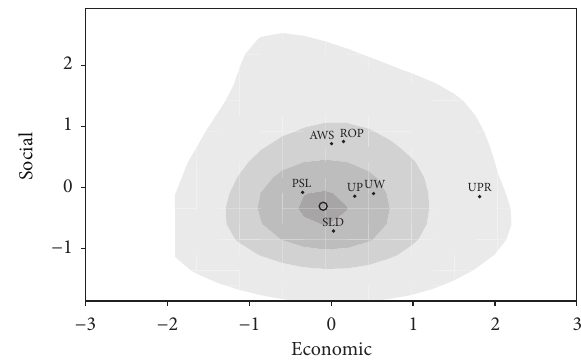
Figure 9: Voter distribution and party-positions in Poland in 1997.